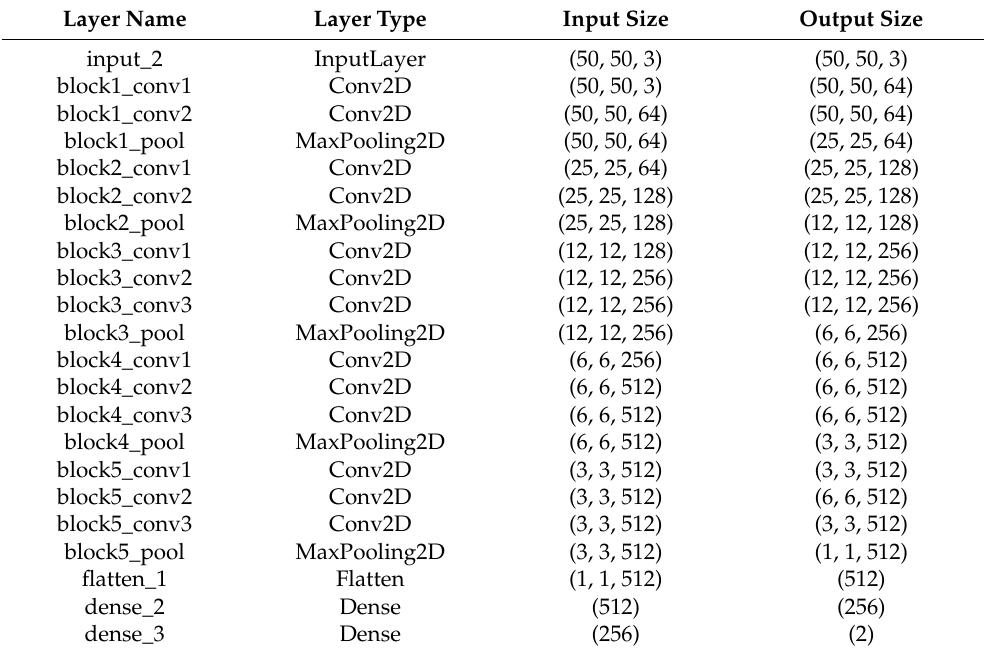
Table 1. Target model